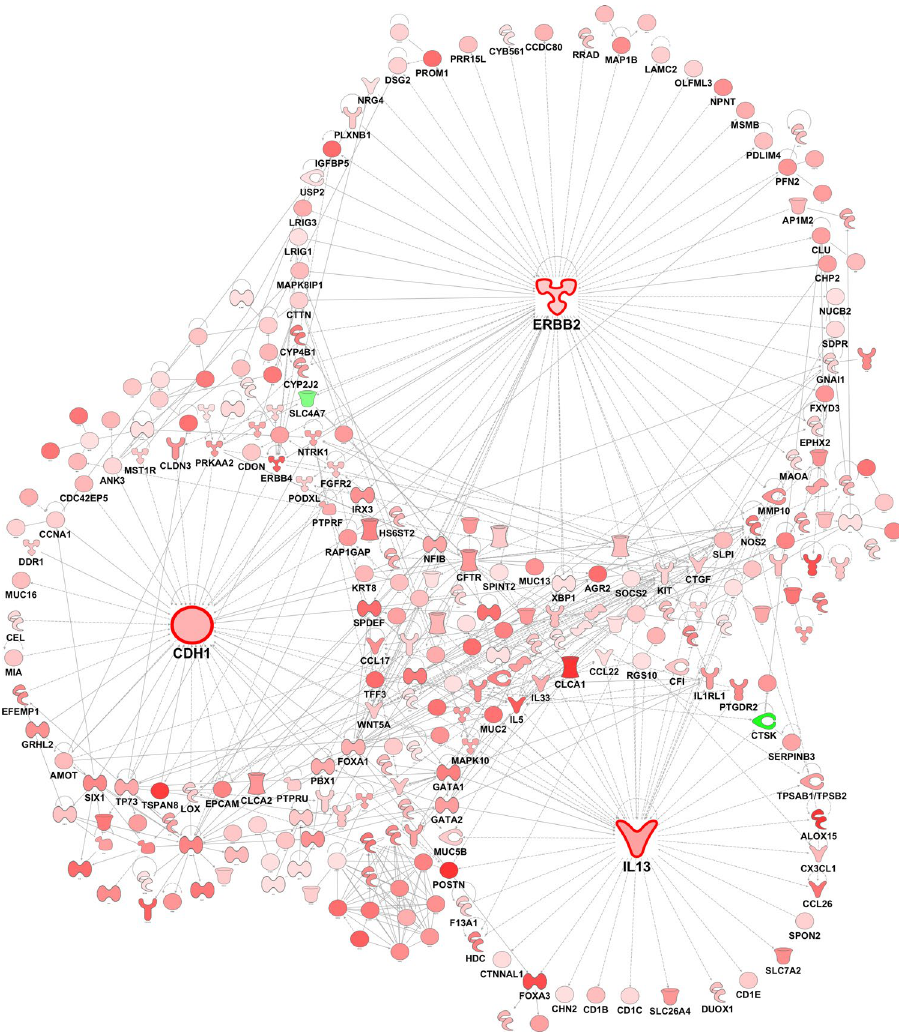
Figure 2. Differential gene network comparing HDM S wheezers versus nonatopic controls. Differentially expressed genes were identified with an edgeR analysis. Gene expression patterns in sputum were compared between HDM S wheezers and nonatopic controls. The wiring diagram of the underlying gene network was reconstructed using prior knowledge from the literature (Ingenuity Knowledge Base). Genes highlighted in red denote upregulation, whilst molecules in green indicate downregulation in HDM S